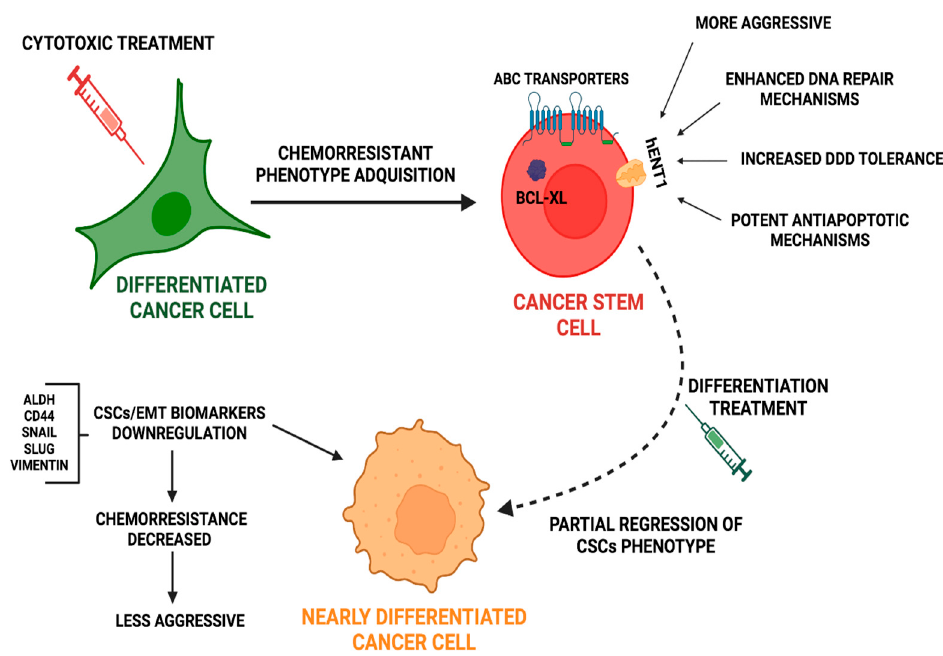
Figure 3. Cytotoxic treatments induce cancer stem cells phenotype acquisition together with increased chemoresistance. Approaches to re-differentiate CSCs could improve current treatment. After cytotoxic treatment, differentiated cancer cells acquire a quiescent CSCs-like phenotype, through the successful repair of damaged DNA. CSCs, after cytotoxic assault trigger protective mechanisms, such as the expression of ABC transporters and mechanisms to repair DNA, to increase tolerance to DDDs and to avoid apoptosis. Novel strategies focusing on new non-toxic anticancer compounds could induce regression of the CSC phenotype toward a differentiated phenotype with less chemoresistant potential.